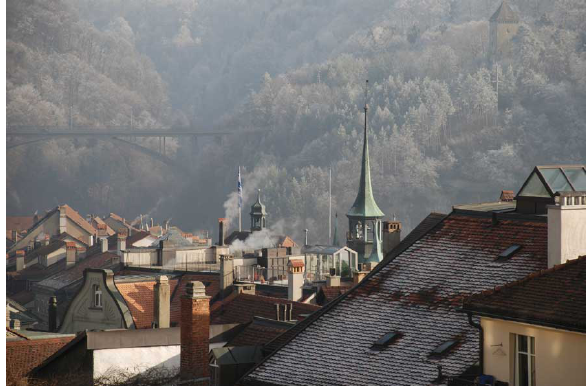
Figure 2. Roofs in the historic city center of Fribourg c (cid:13) City of Fribourg Copyright 2017,